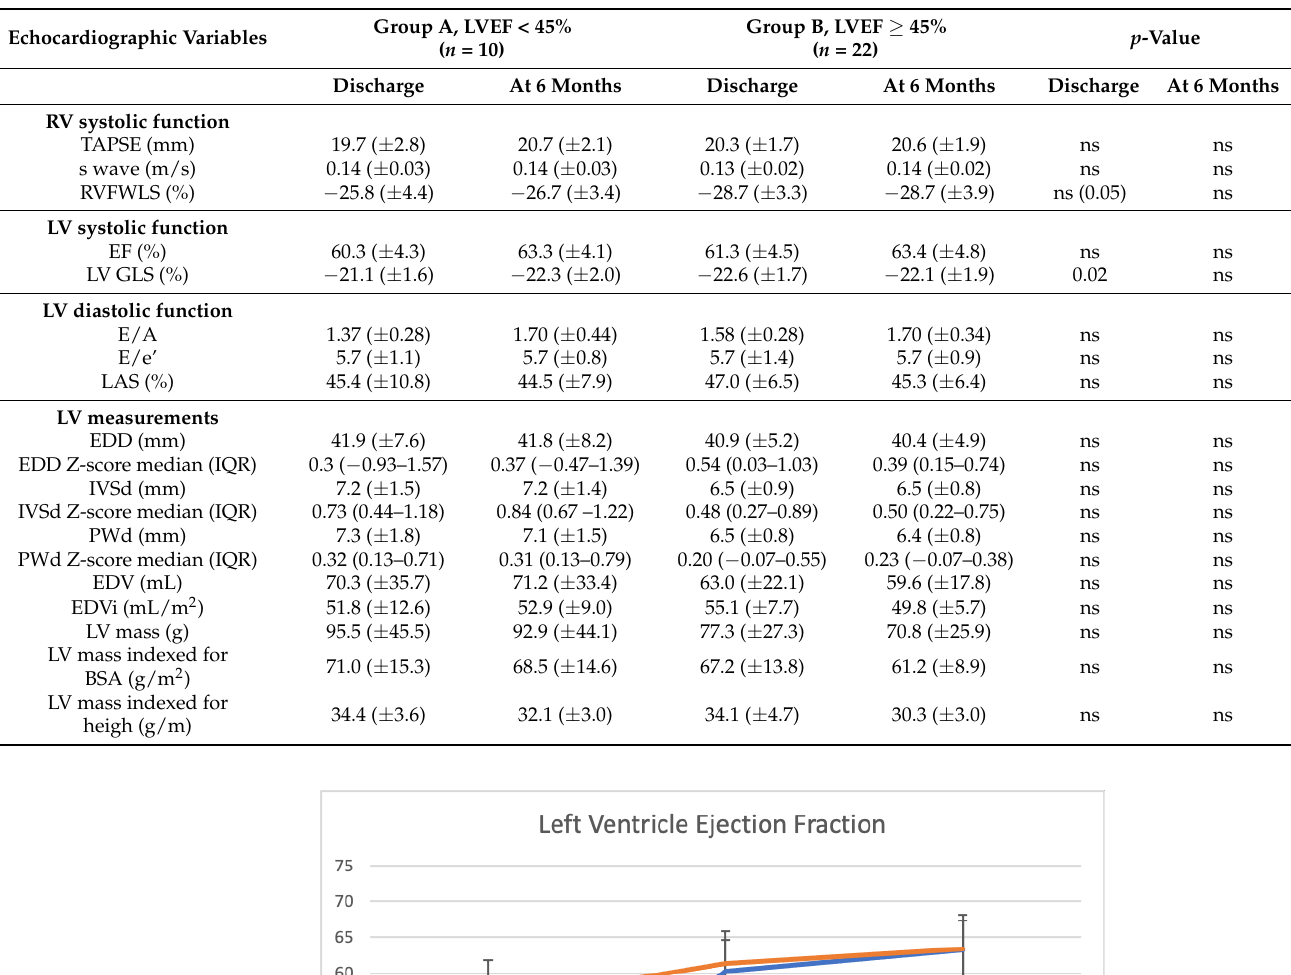
Table 3. Results of echocardiographic parameters in the early (discharge) and late (6 months follow- up) evaluation, divided into group A and group B. Variables are expressed in mean ( ± standard deviation) and median (and interquartile range) for Z-score values. Legend. BSA (body surface area), EDD (end-diastolic diameter), EDV (end-diastolic volume), EDVi (end-diastolic volume indexed for body surface area), EF (ejection fraction), IVSd (interventricular septum diastolic), LAS (left atrium strain), LV GLS (left ventricle global longitudinal strain), ns (not significant), PWd (posterior wall diastolic), RVFWLS (right ventricle free wall longitudinal strain), TAPSE (tricuspid annular plane systolic excursion).